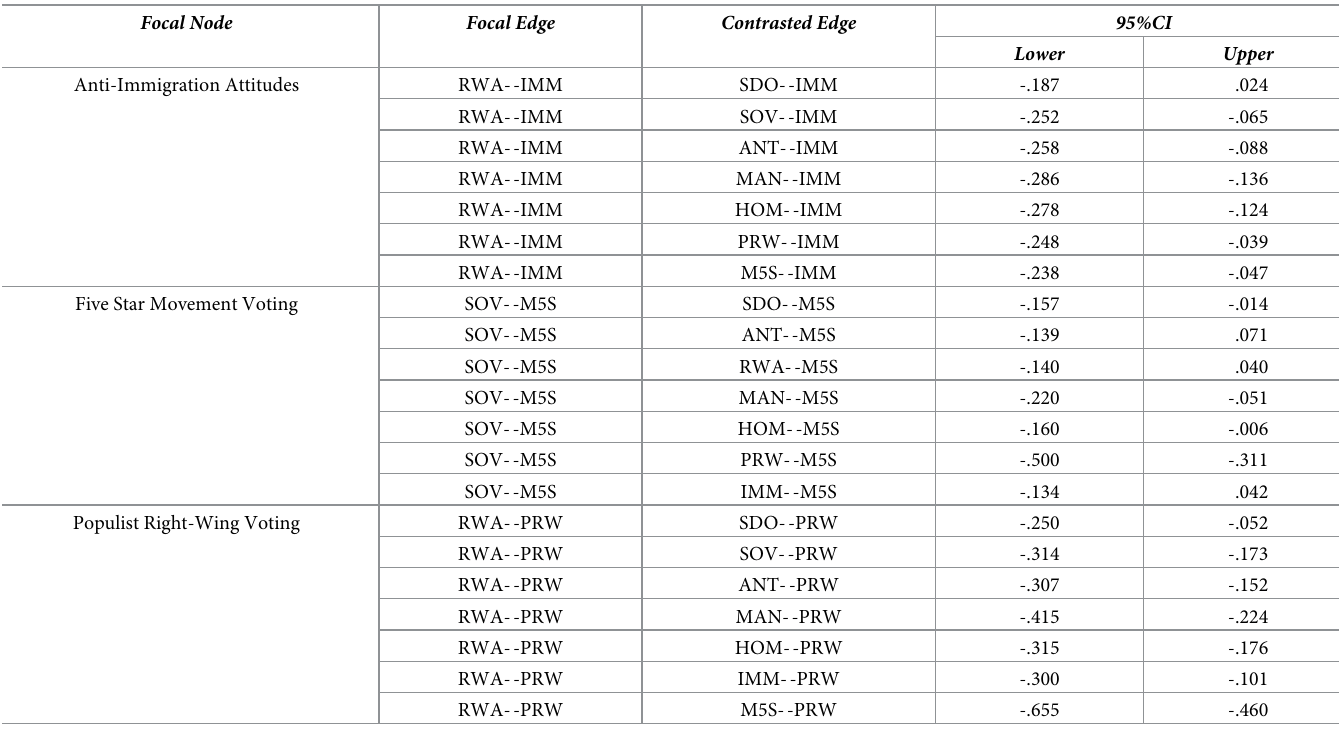
Table 7. Pairwise contrasts of edge-weights’ strength for anti-immigration attitudes and populist voting. Focal